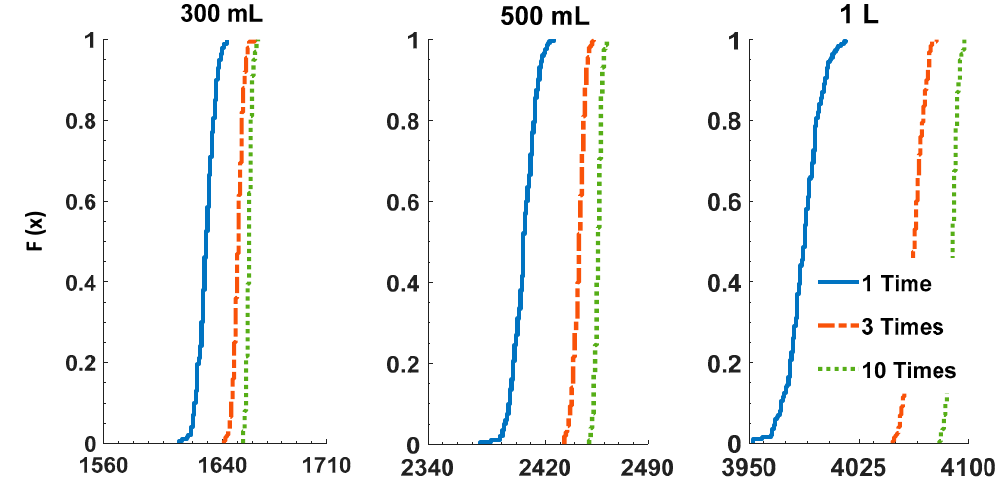
Figure 5. Impact of consumption volumes and number of glasses per day on the number of infected people corresponding to median infection risk over a four day-period; Cryptosporidium concentration = 560 oocysts/L; the x-axis scale is the same between the plots (150 people). Duration. Shorter duration PDCs can take place in real networks because of WTP shutdowns, pipe breaks or fire flows. The cumulative probability distribution of the number of infected people for 200 random consumption behaviors is shown for different durations of PDCs: 1, 10, and 24 h (Figure 6). In all scenarios, the timing of the event was adjusted so that the network experienced low/negative pressures at the peak consumption time (i.e., 19:00) of the first day. A significant dependence of the infection risk with the intrusion duration was observed: a lower maximum number of infected people (84) was observed for a 1-h intrusion compared to 502 and 1410 for 10 and 24 h intrusion events, respectively. Figure 6. Comparing the probability distribution of the number of infected people over a four-day period for 200 Monte Carlo simulations for each duration of PDCs: 1, 10, and 24 h; Cryptosporidium concentration in sewage = 560 oocysts/L.